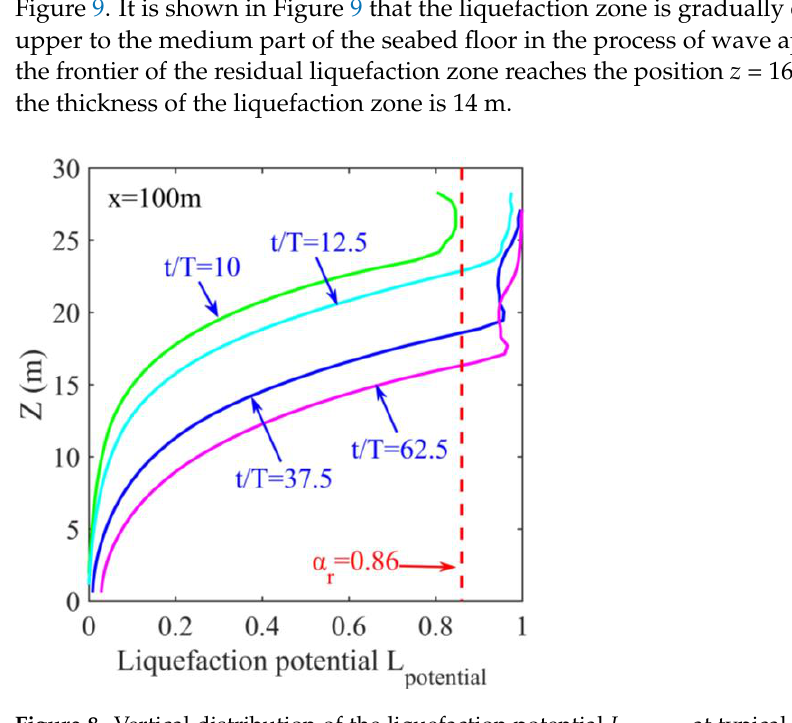
Figure 9. Cnoidal wave-induced residual liquefaction zone in loose seabed floor at typical time t / T = 10, 25, 50, and 62.5. The above analysis has more or less implied that the residual liquefaction first occurs in the upper part, and then gradually transmits toward the lower part of the seabed floor. Figure 10 exactly proves this progressive process. It is observed that the residual liquefac- tion first occurs at the seabed surface, and then the liquefaction zone gradually enlarges